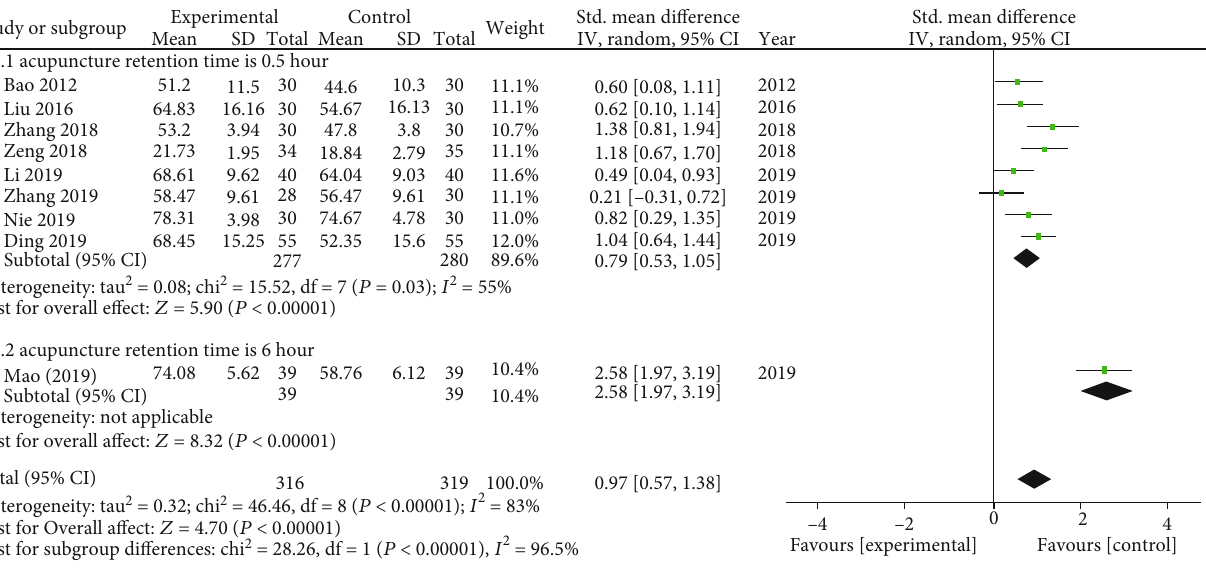
Figure 7: The forest plots of activities of daily